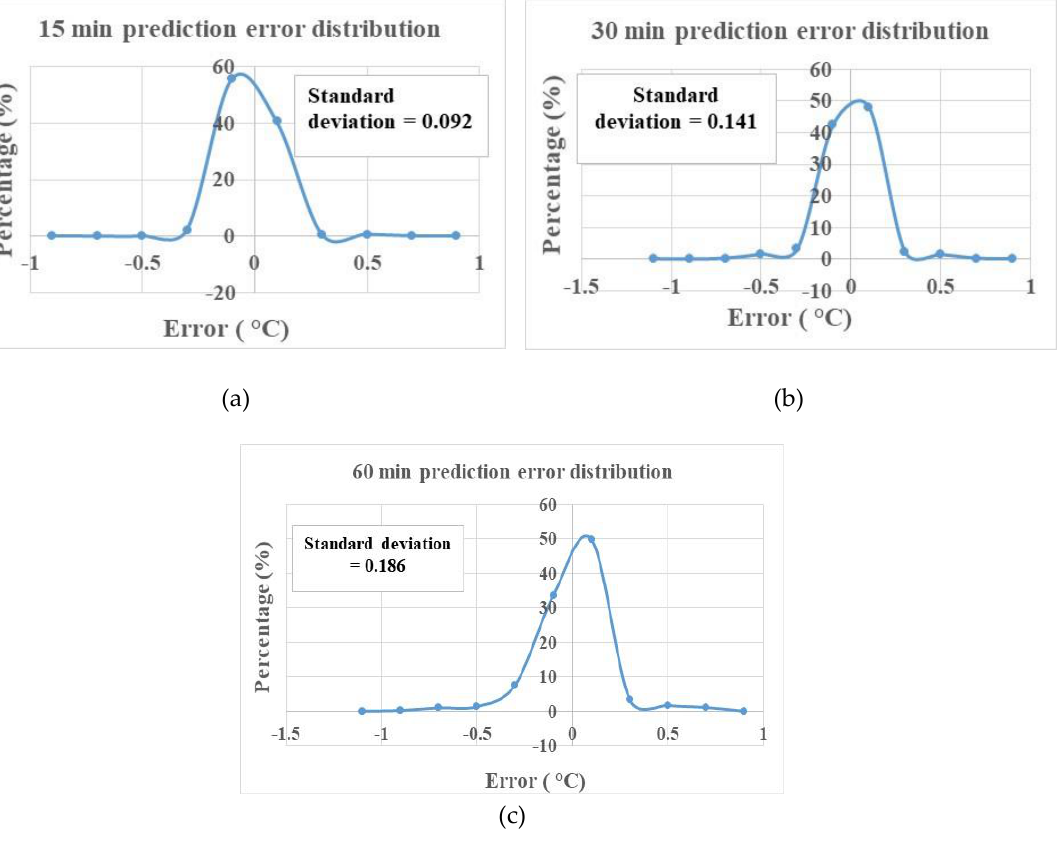
Figure 5. Error distribution for experiment B-order 3: ( a ) 15 min prediction; ( b ) 30 min prediction ( c ) 60 min prediction.